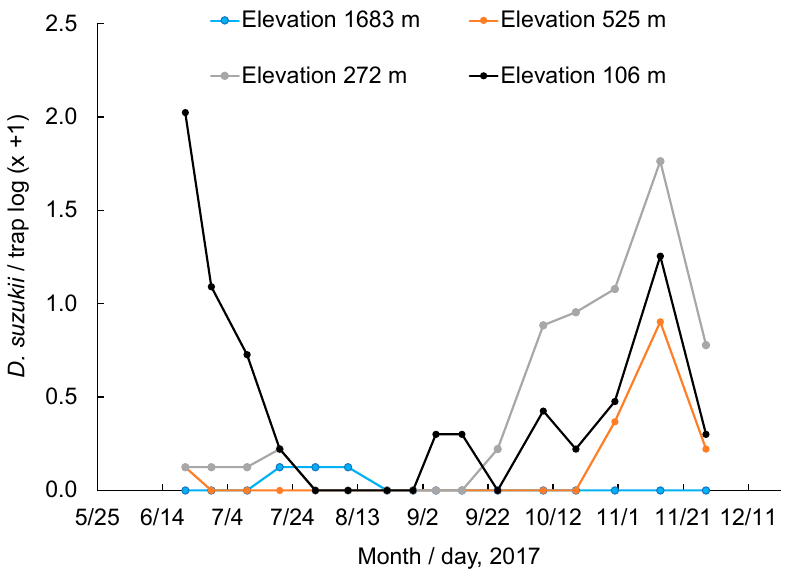
Figure 5. Weekly mean D. suzukii trap captures in cedar vinegar traps at different elevations in the San Joaquin valley and its nearby foothills and mountain forest areas.